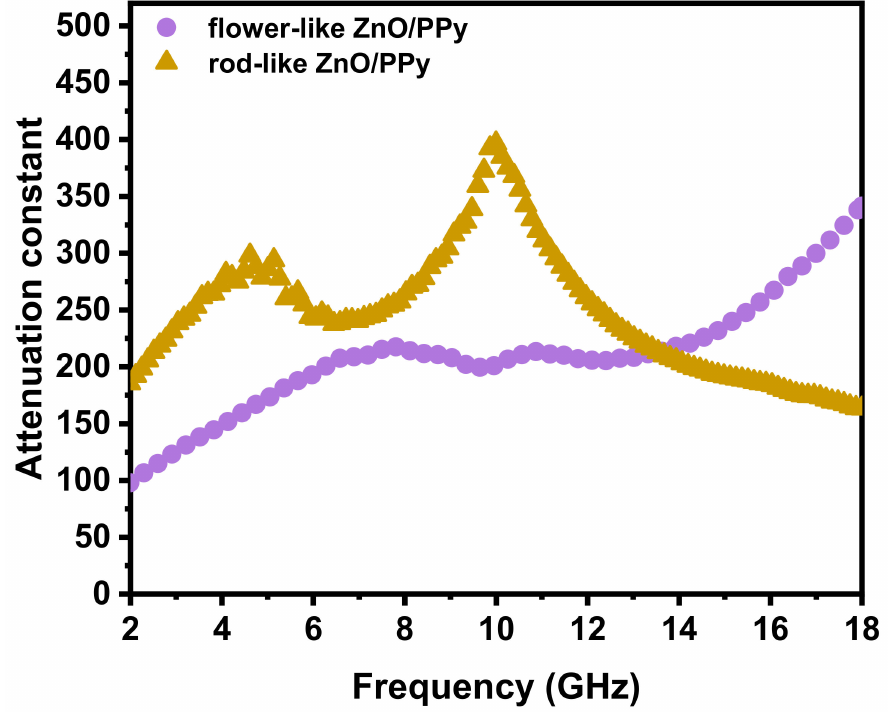
Figure 8. Microwave attenuation constant ( α ) of flower-like and rod-like ZnO/PPy